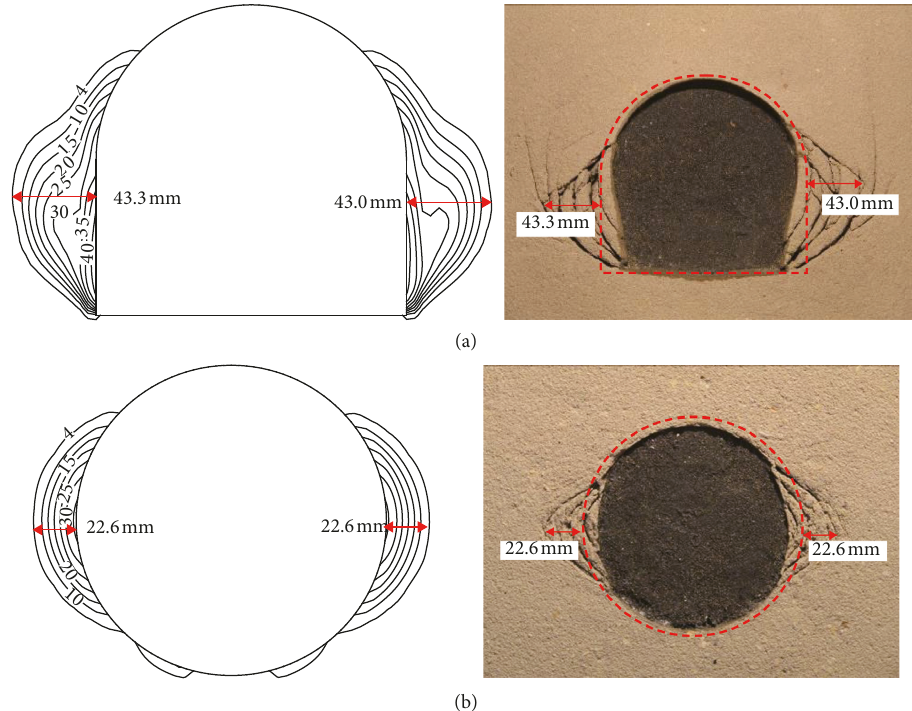
Figure 9: The result of the agreement between the contour line FAI � 4 and the process of crack depth. The results of experimental and numerical simulation of (a) T1 under 6.30MPa and (b) T2 under 5.84MPa.